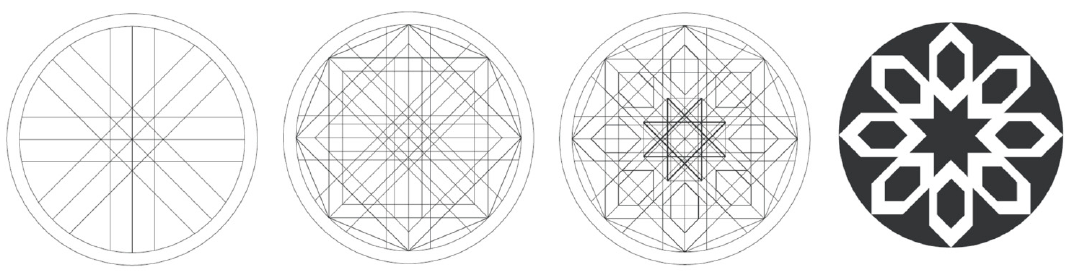
Figure 2. Figure-Ground Relationship.